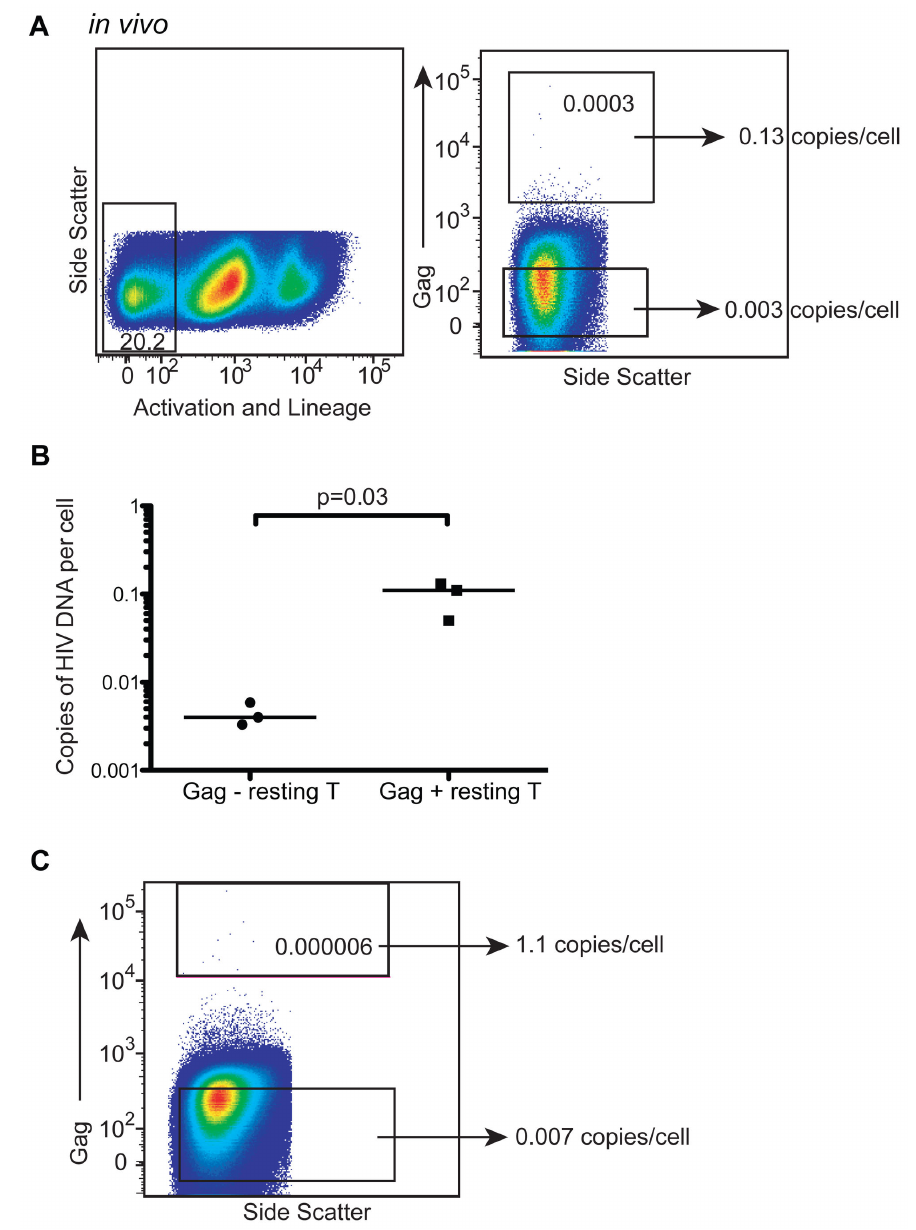
Figure 6. GPR cells are detectable in vivo . (A) Representative sort plots and gating strategies from a treated non-controller showing selection of resting CD4+T cells by lineage (except CD4) and activation markers stained in PE (left plot) and the selection of Gag positive and negative cells (right plot). The numbers inside the boxes represent proportion of resting CD4+T cells. Numbers outside of the boxes represent the copies of HIV DNA per cell. TP1 in Table